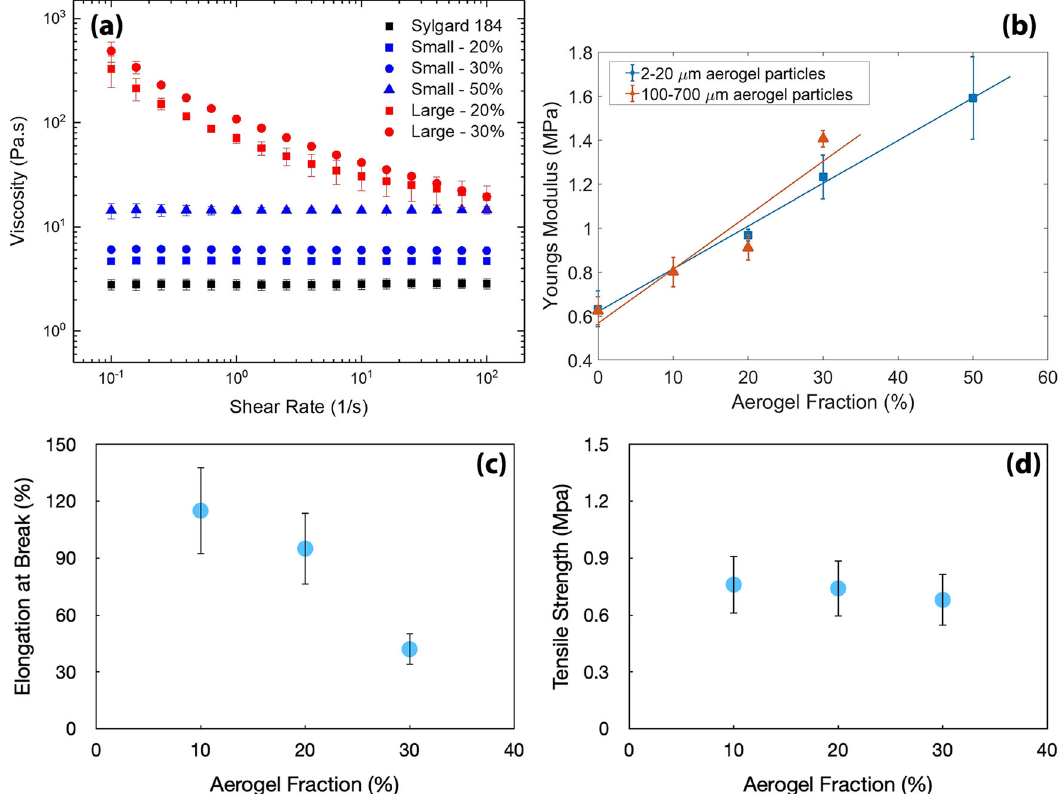
Fig. 3 Mechanical properties of uncured and cured aerogel – silicone composites. a Viscosity of the uncured elastomer. b Young ’ s modulus of the composite plotted against the aerogel volume fraction for two different aerogel particle sizes. c Percent elongation at break plotted as a function of the aerogel volume fraction. d Tensile strength of the composite plotted against aerogel volume fraction. Error bars indicate standard